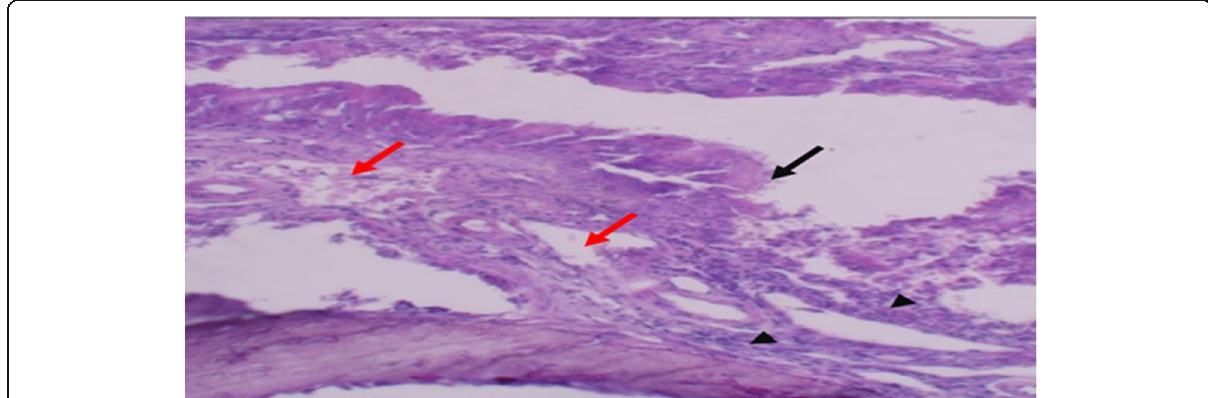
Fig. 3 Nasal mucosa (group 2) characterized by disrupted nasal tissue, ulcerated epithelial covering, markedly dilated blood vessels in the lamina propria (red arrow), and mild inflammatory reaction (H&E,